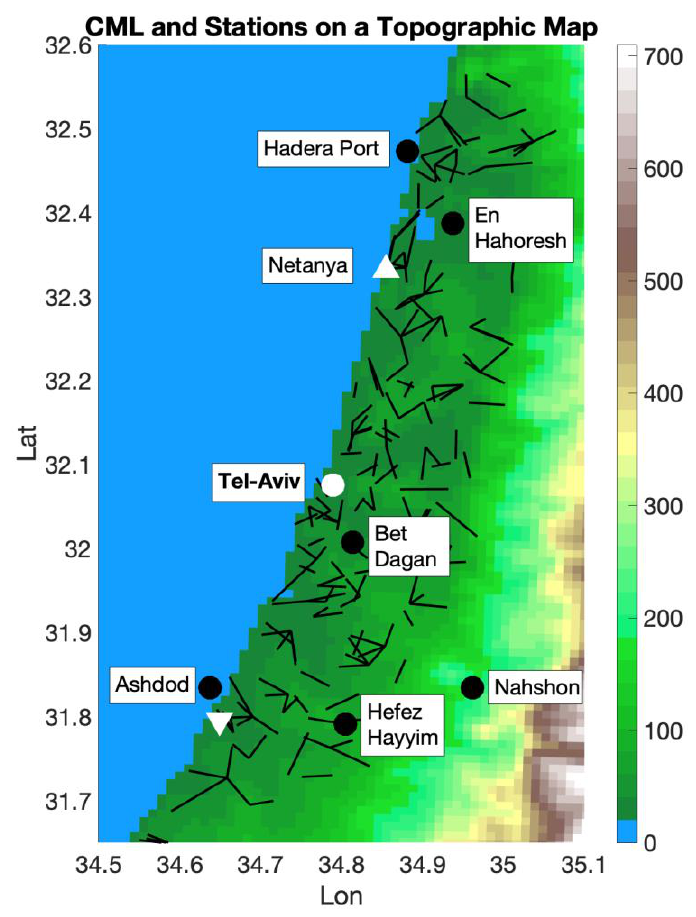
Figure 2. CMLs (black lines) and 7 IMS (Israeli Meteorological Service) weather stations (denoted by the black circles and their names; see Table S1) on a topographic map (https://www2.mmm.ucar.edu/wrf/users/download/get_sources_wps_geog.html, accessed on 23 October 2022). The white circle denotes the coastal city of Tel Aviv; white triangles indicate the coastal cities of Netanya (upward) and Ashdod (downward).